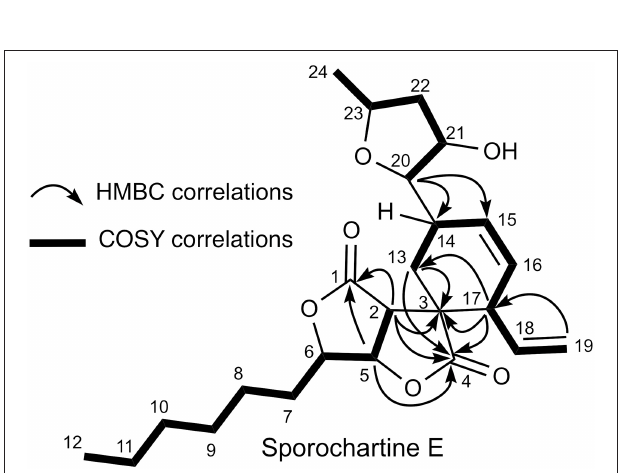
FIGURE 5 | COSY and HMBC key connectivities for sporochartine E ( 5 ).